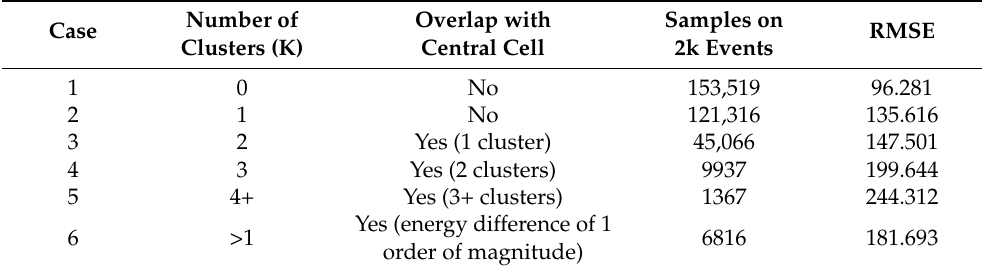
Figure 4. Samples of the data used for the training of the clustering and overlap network. The three streams of data ( c – e ) are extracted from the analysis of a 7 7 window ( a ). Image ( b ) shows the output predicted by the network representing the reconstructed cluster located at the centre of the ( a ) sample. Table 2. Case characteristics in the balanced dataset for the MLP training. Case 6 is a selection of samples with overlap with at least one cluster, but where the energy difference between clusters is bigger than an order of magnitude. The RMSE values were extracted, comparing the network predicted values and the samples generated with the application of the CA rule.